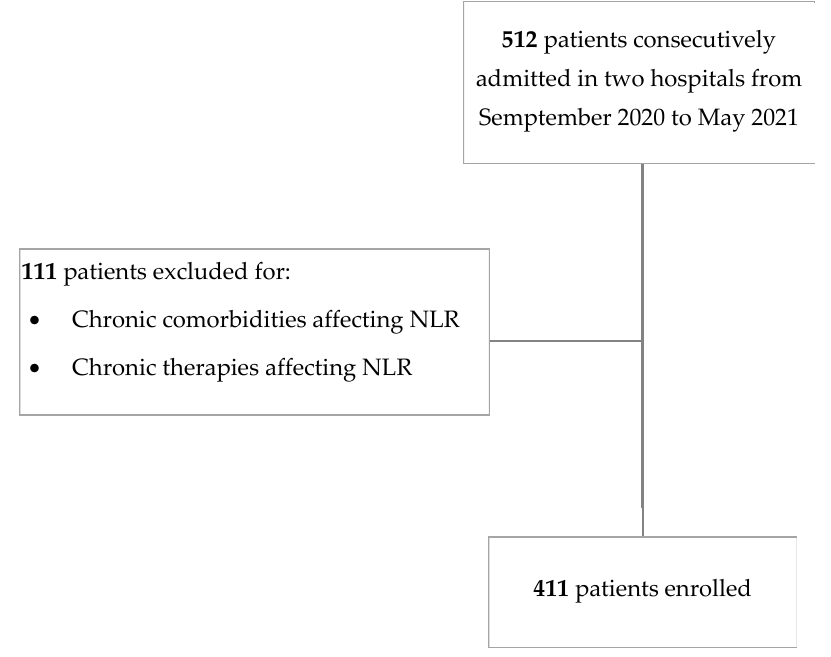
Figure 1. Flow chart of patient selection. NLR = Neutrophil-to-lymphocyte ratio.